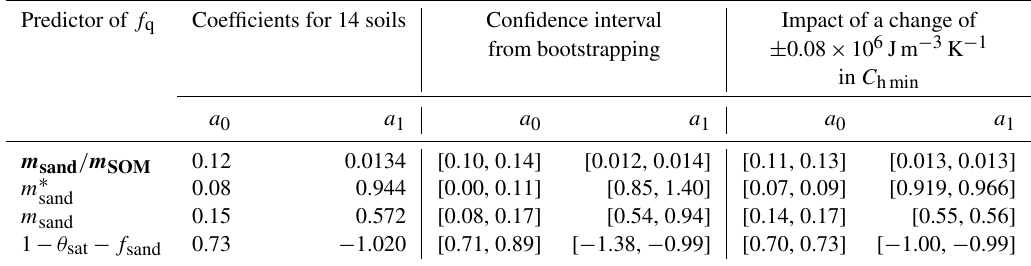
Table 3. Coefficients of four pedotransfer functions of f q (Eq. 12) for 14 soils of this study (all with m sand /m SOM < 40), together with indicators of the coefficient uncertainty, derived by bootstrapping and by perturbing the volumetric heat capacity of soil minerals ( C hmin ). The best predictor is in bold.